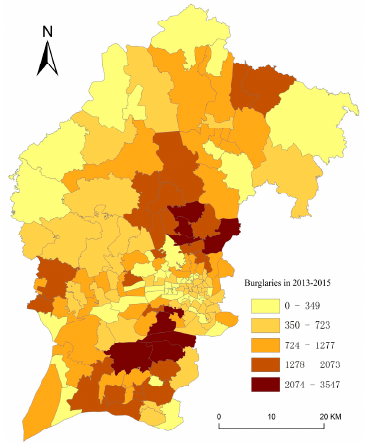
Figure 1. Spatial distribution of residential burglaries in 2013–2015.